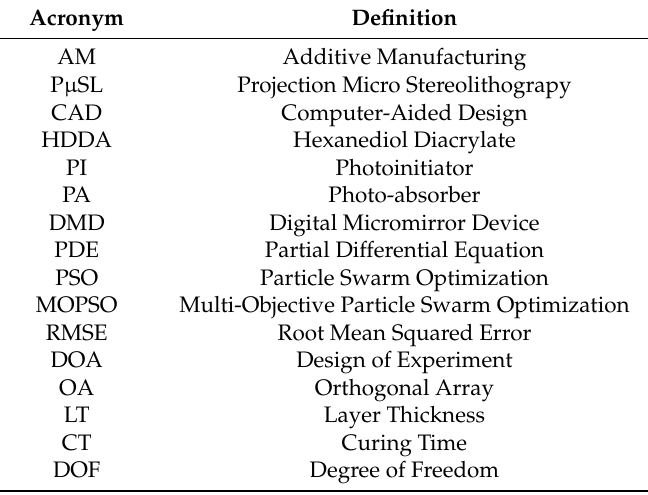
Table A2. Table for